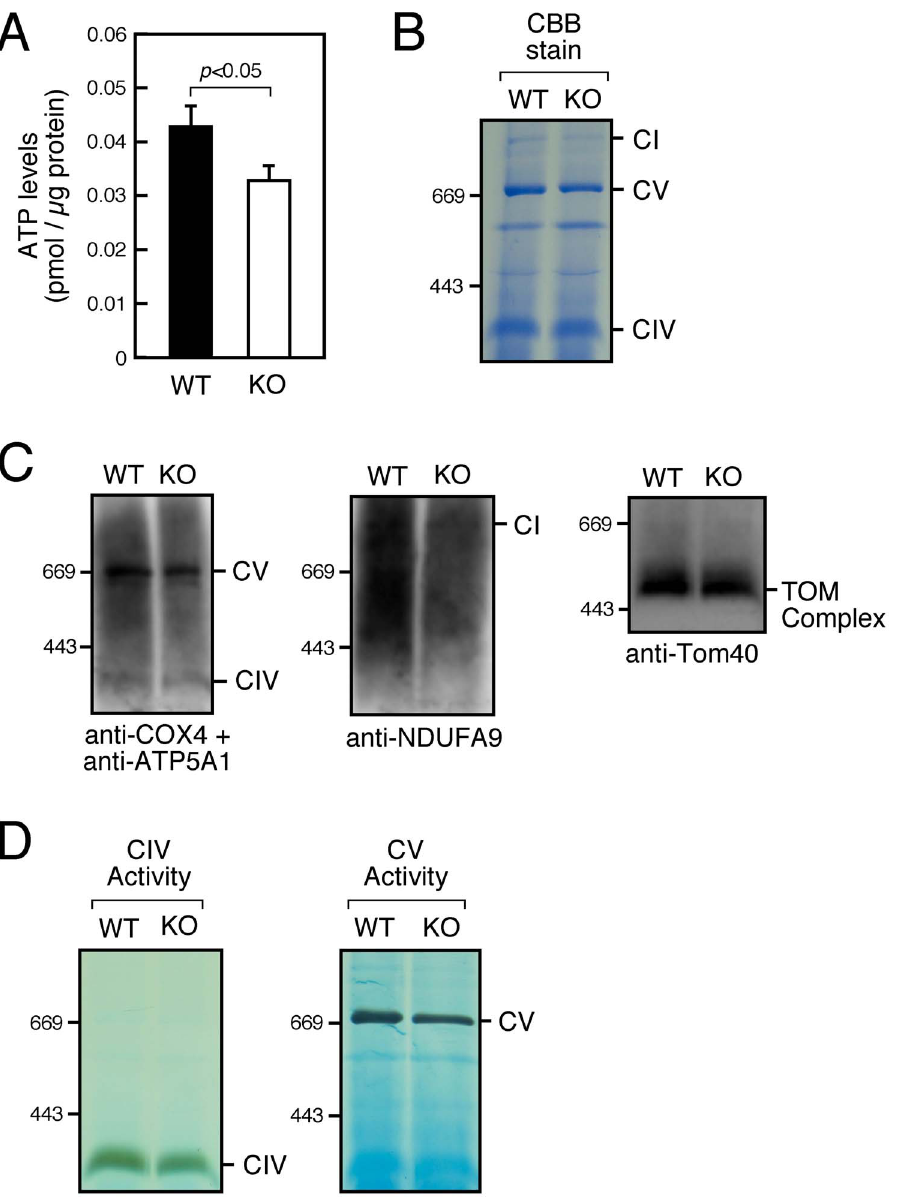
Figure 5. Mitochondrial function is disrupted in SMS1-KO WAT. (A) ATP content in WAT was measured (WT, n =10; KO, n =10). (B and C) Formation of respiratory complexes in WAT mitochondria was analyzed by BN-PAGE, followed by Coomassie blue staining (B) and immunoblot analysis (C). The complexes I, IV and V were detected by using anti- a s9 (NDUFA9), anti-COX4 and anti-ATP5A1 antibodies, respectively. TOM complex was detected by using anti-Tom40 antibody. (D) Activity of complexes IV and V was assessed (see MATERIALS AND METHODS). CI, complex I; CIV, complex IV; CV, complex V.